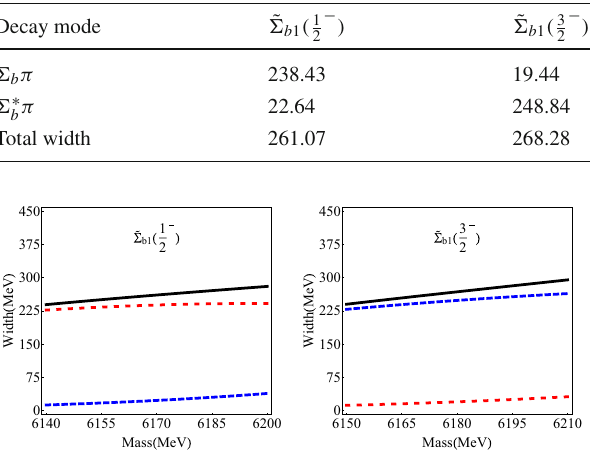
Fig. 7 The total decay widths for the ˜ (cid:4) c ( 1 P ) states versus their initial masses. The black lines correspond to the total decay widths. The red dotted and blue dashed lines stand for the partial decay widths of (cid:4) c π and (cid:4) ∗ c π channels, respectively tively. Their calculated decay widths are presented in Table